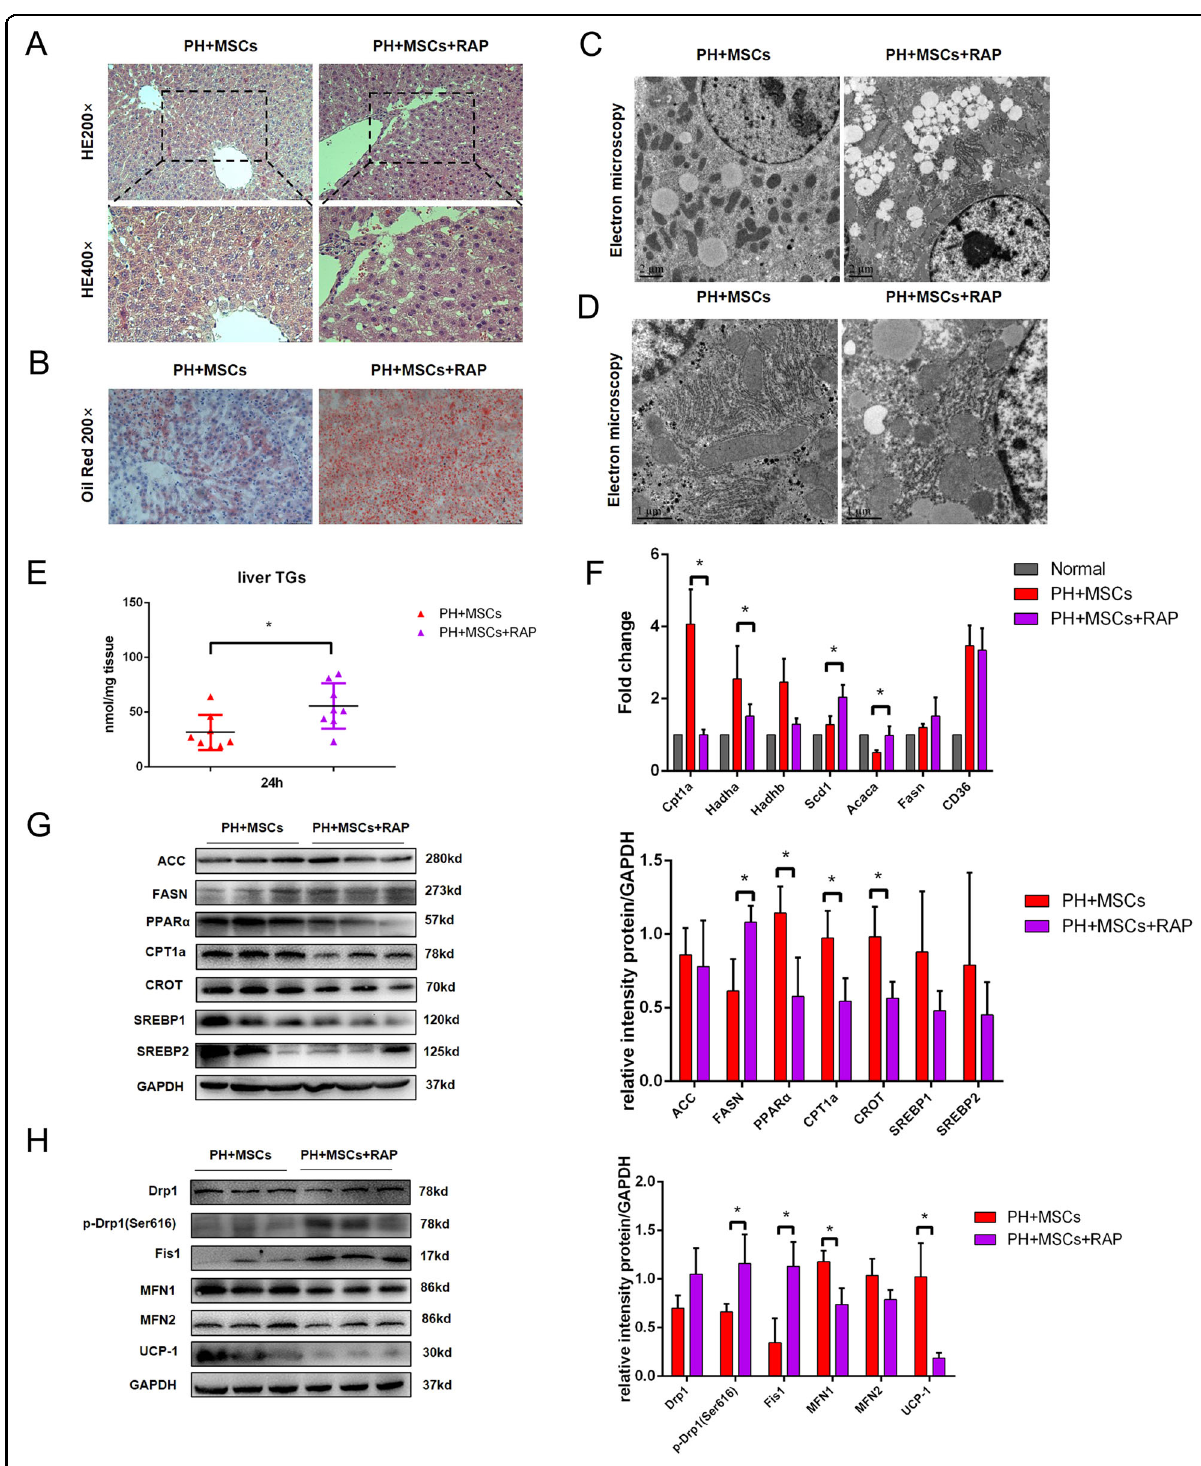
Fig. 5 mTOR pathway is involved in the regulation of MSCs on lipid metabolism. A Liver H&E staining. B Oil red staining of liver tissue. C , D Electron microscopy of liver tissue. E Detection of TG content in liver tissue. F , G Western blotting analysis and RT-PCR of liver lipid metabolism- related genes and proteins. H Mitochondrial dynamic protein detection. * P < 0.05. t -test, data are shown as mean standard